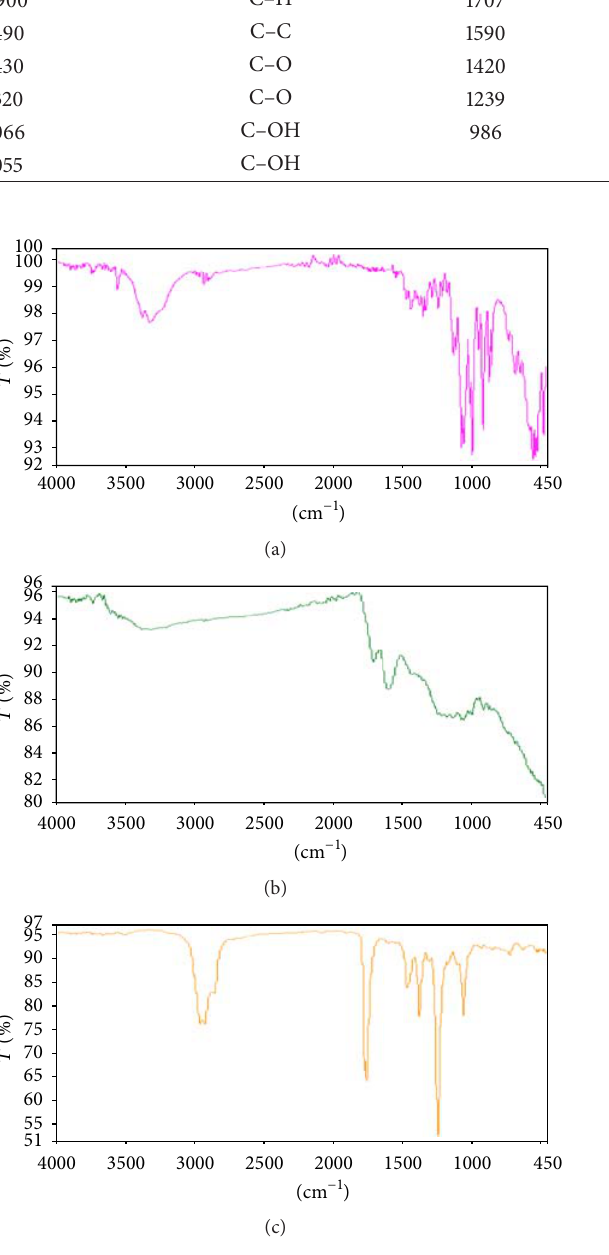
Figure 3: Raw FTIR spectra of sucrose (a), carbonized sucrose (b), and carbonized + sulphonated sucrose